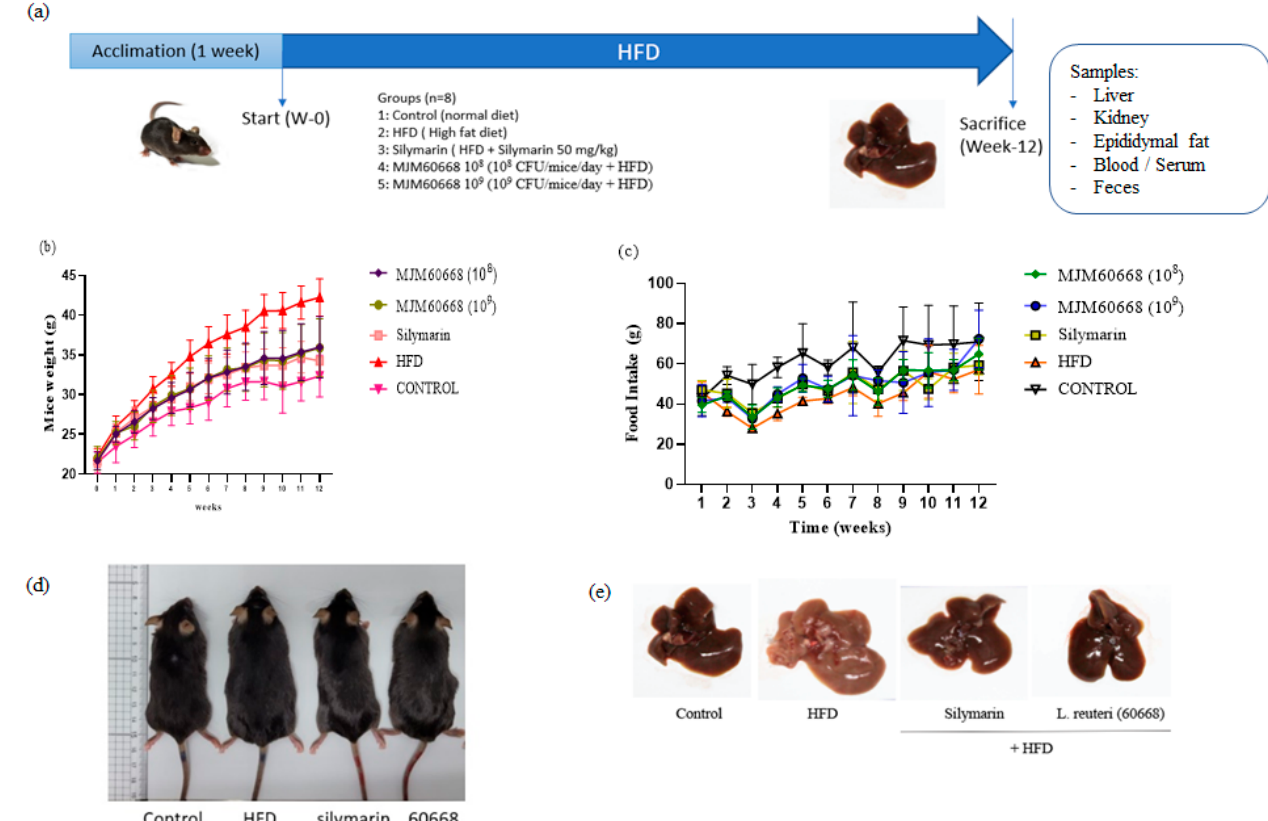
Figure 3. ( a ) Diagram of mouse model. Mice were divided into 5 groups: Control group, HFD group, Silymarin group, MJM60668 (10 8 ) group, and MJM60668 (10 9 ) group. The HFD, Silymarin, and MJM60668 groups were fed an HFD diet and free water daily. Moreover, mice in the Silymarin group were also treated with silymarin at (50 mg/kg), MJM60668 (10 8 ) were treated with L. reuteri at a concentration of 1 × 10 8 CFU, daily, and MJM60668 (10 9 ) were treated with L. reuteri at a concentration of 1 × 10 9 CFU, daily. ( b ) body weight recording weekly for 12 weeks of the experiment. ( c ) Food intake per cage recording weekly. ( d ) Comparative image with body shape mice before sacrifice. ( e ) Image with liver after sacrifice.